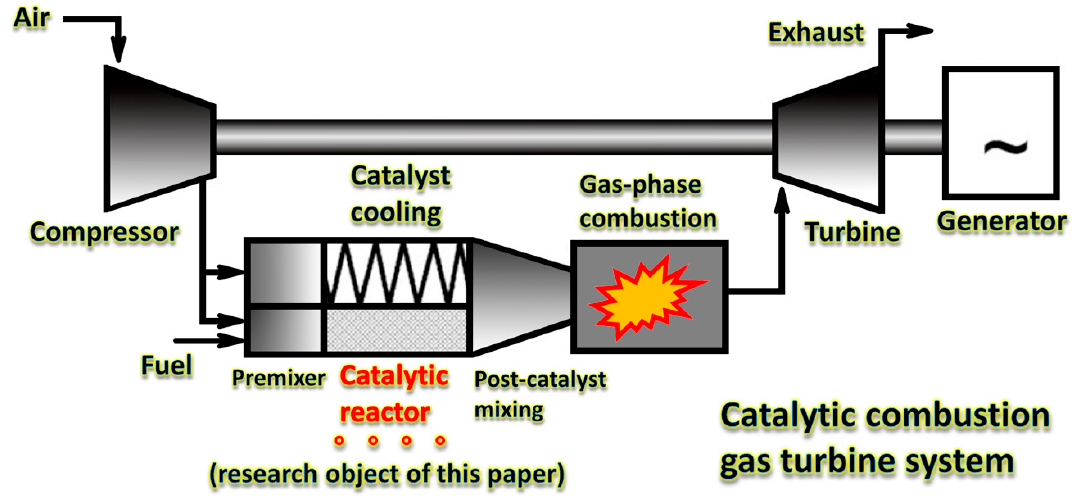
Figure 1. Schematic diagram of the catalytic reactor in a catalytic combustion gas turbine system. The catalytic reactor is the research object of this paper.